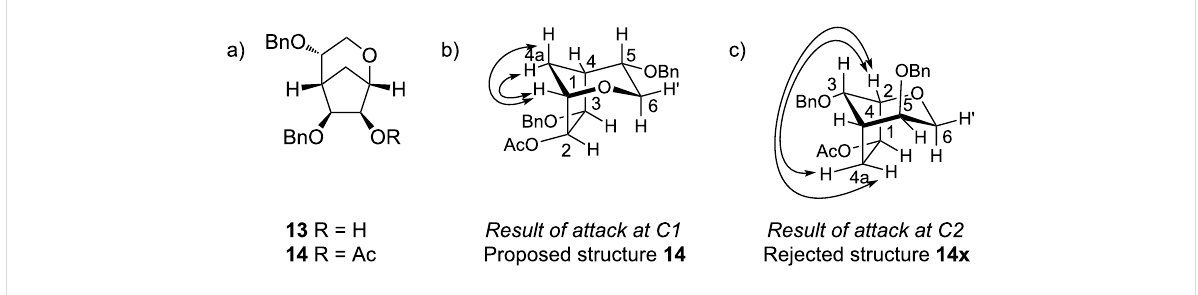
Figure 2: a) Structures of 13 and 14 ; b) observed NOEs consistent with structure 14 ; c) observed NOEs inconsistent with structure 14x